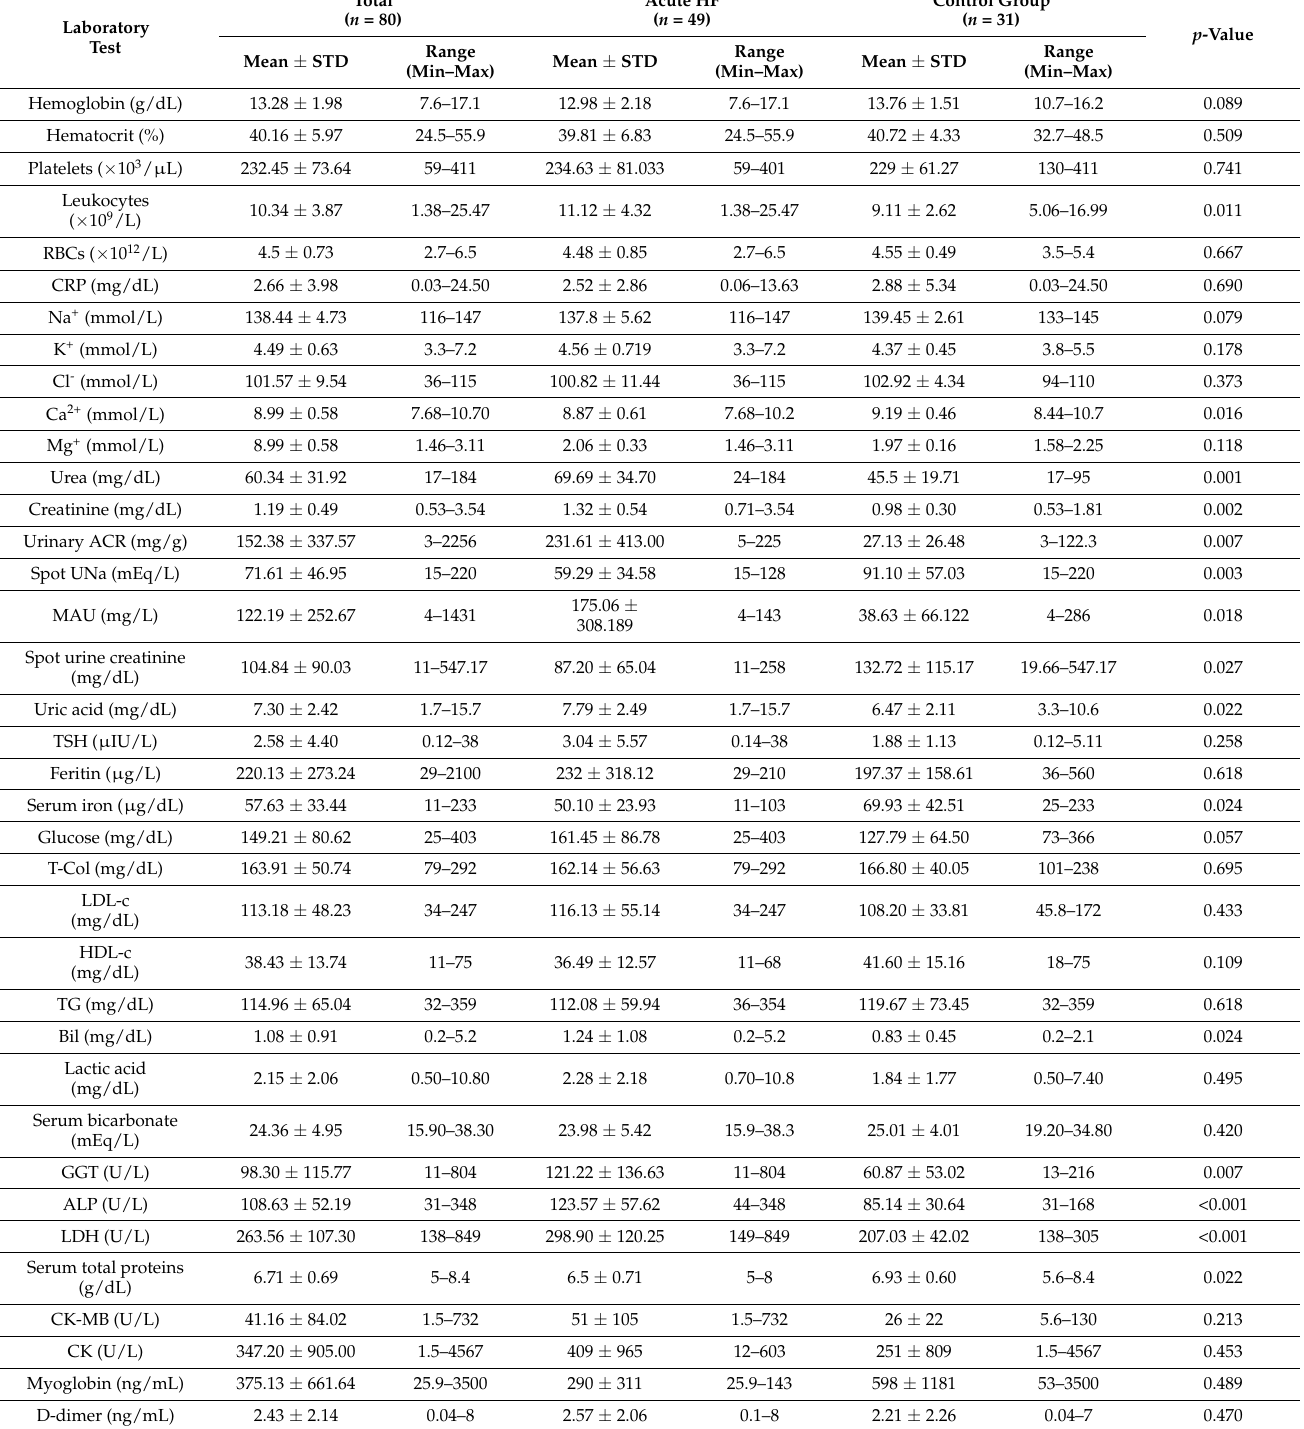
Table 3. Laboratory findings in AHF and control